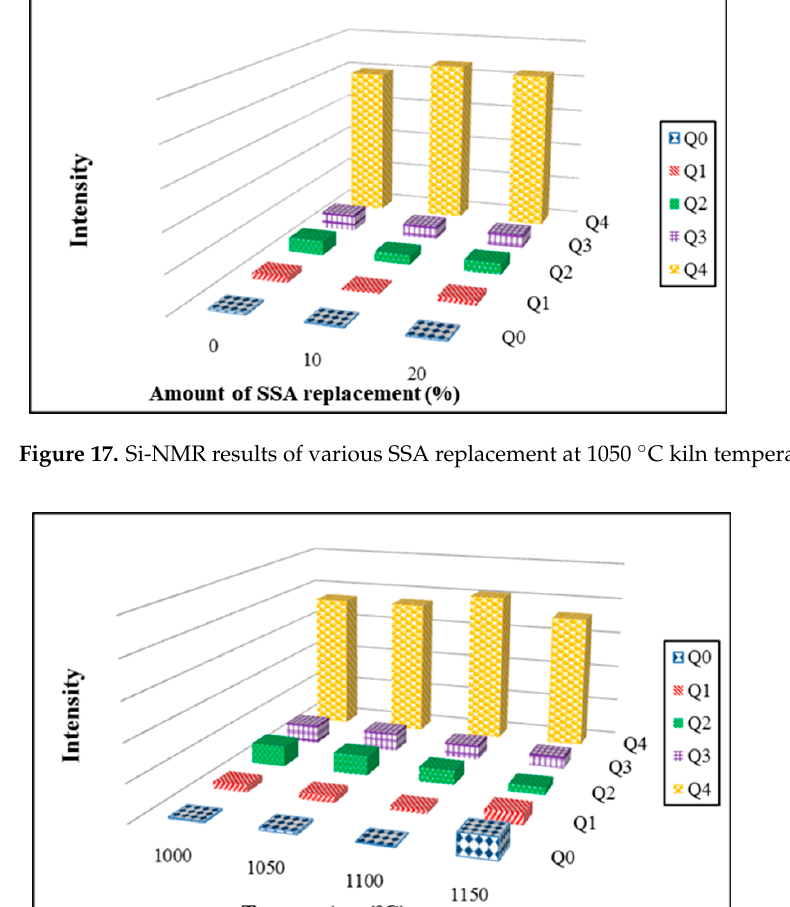
Figure 17. Si ‐ NMR results of various SSA replacement at 1050 °C kiln temperature.